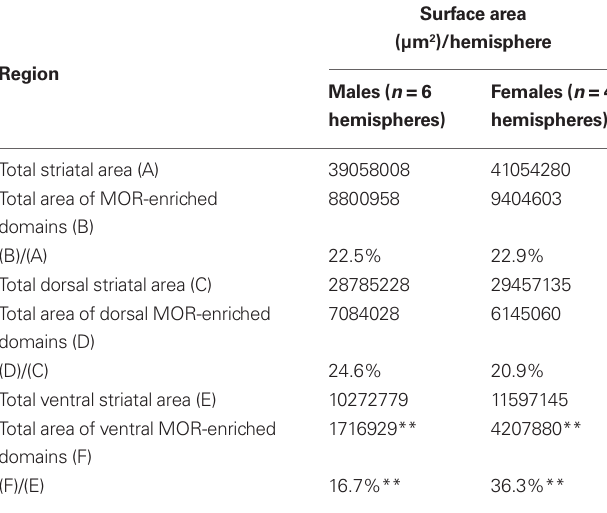
Table 2 | Cavalieri estimations of surface area measurements obtained from 60 μm serial sections at 300 μm intervals that were used for stereological counting and mapping of TH-eGFP neurons with respect to